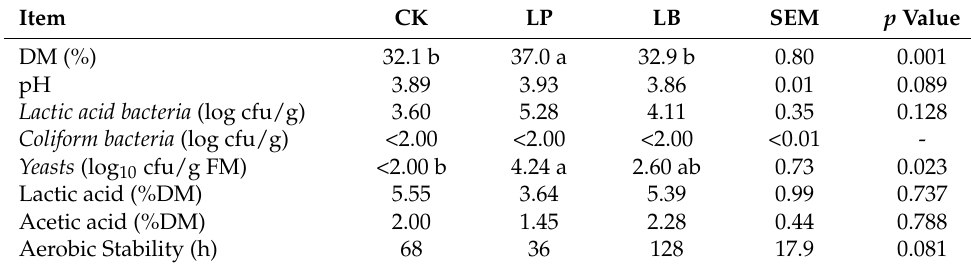
Table 1. Fermentation quality and aerobic stability of whole crop corn silage [12].